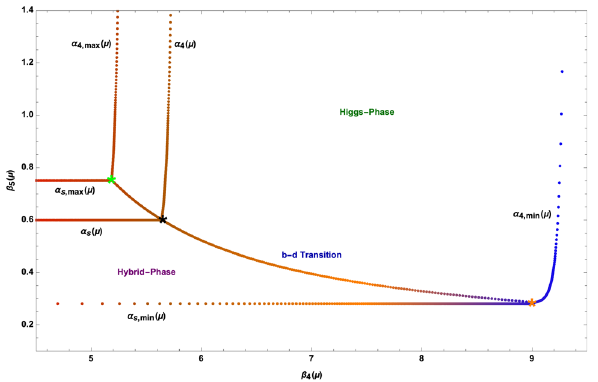
Fig. 9 The running of the couplings α 4 (μ) and α s (μ) (Higgs and Fig. 11 The Lines of Constant Physics (green, black and orange line) hybrid phase respectively) as the RG flow moves towards the phase fortheboundary-hybrid modelintheHiggsphase.Alongtheselinesthe transition in the UV. When the cut-off scale is reached the RG flows massratioandthescalarmassarekeptfixed.However, onlythecurveof ρ hit the point ∗ of the phase transition. Here we show three pairs of RG bh ∗ (blackline)correspondstotheStandardModelspectrum.Theother flows whose end points are located at μ ∗ , min (cid:12) 136 . 1 GeV (green star), twoLCPrefertothecases ρ bh , min ∗ < ρ bh ∗ (orangeline)and ρ bh , max ∗ > μ ∗ (cid:12) 209 . 1 GeV (black star) and μ ∗ , ρ (cid:12) 5123 GeV (orange star) α (μ) and α (μ) (magenta lines) for s max bh ∗ (green line). The RG flows of 4 respectively. The flow whose cut-off is μ ∗ and whose flow ends on the these three cases have also been drawn for a comparison with the black star generates the Standard Model spectrum